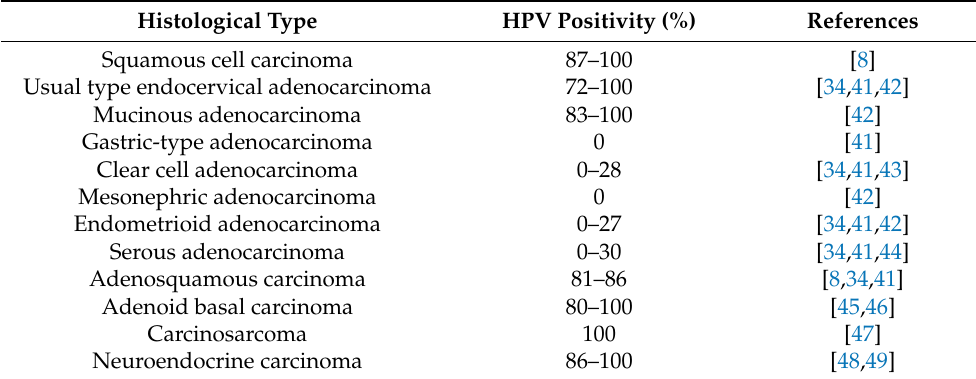
Table 2. HPV infection rates in different histological types of cervical